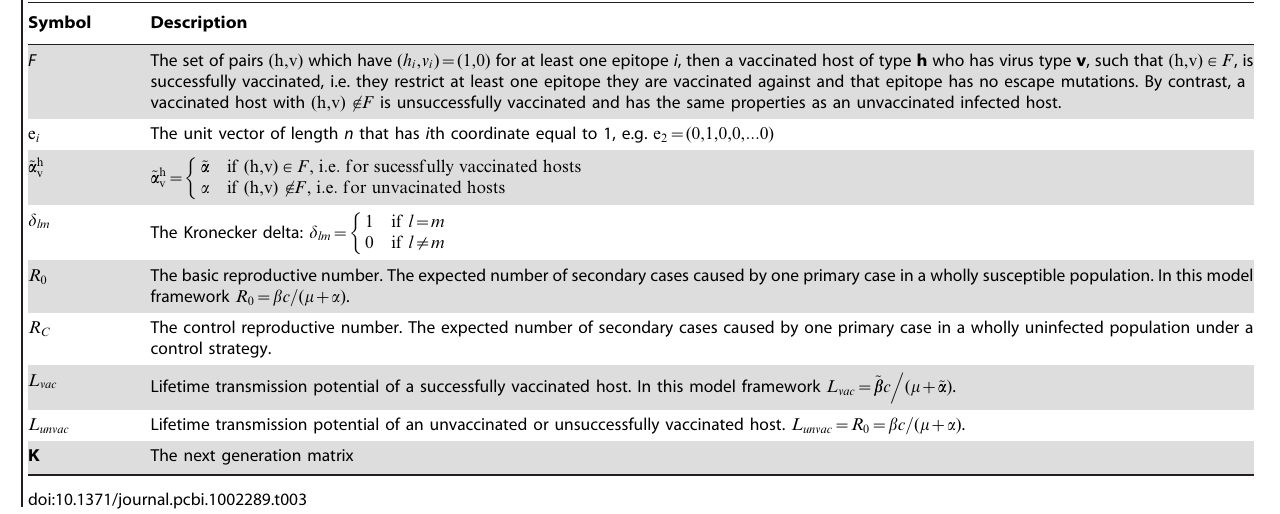
Table 3. Additional terms referred to in the text.